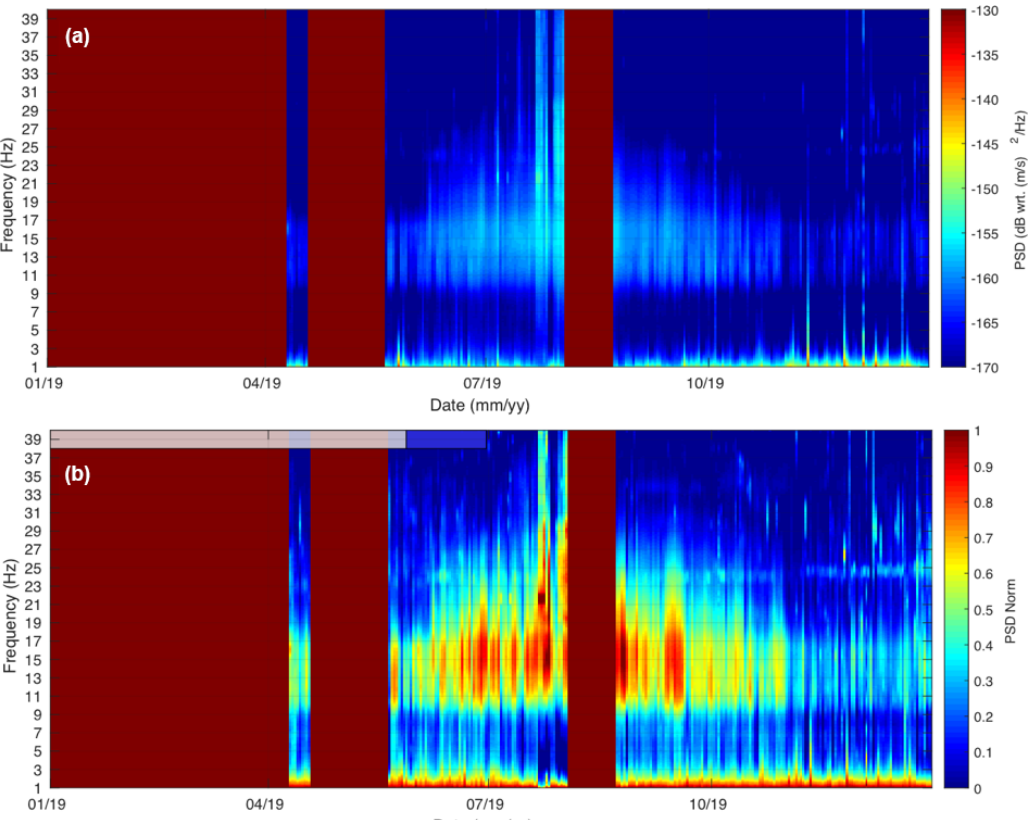
Figure C1. Daily raw (a) and normalized (b) spectrograms of power spectral density (PSD) from OGSA station, located at 2km from the Laurichard rock glacier, in a stable site, for all of the year